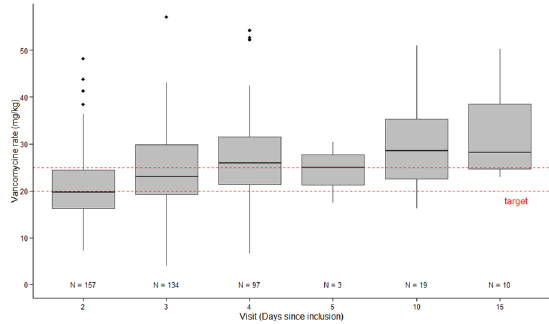
Fig. 1 Vancomycin serum concentration throughout the follow‑up (24 h of administration was defined as D2; D3 to D15 were the following days) P‑123 Psychiatric profile of patients hospitalized in intensive care unit for suicide